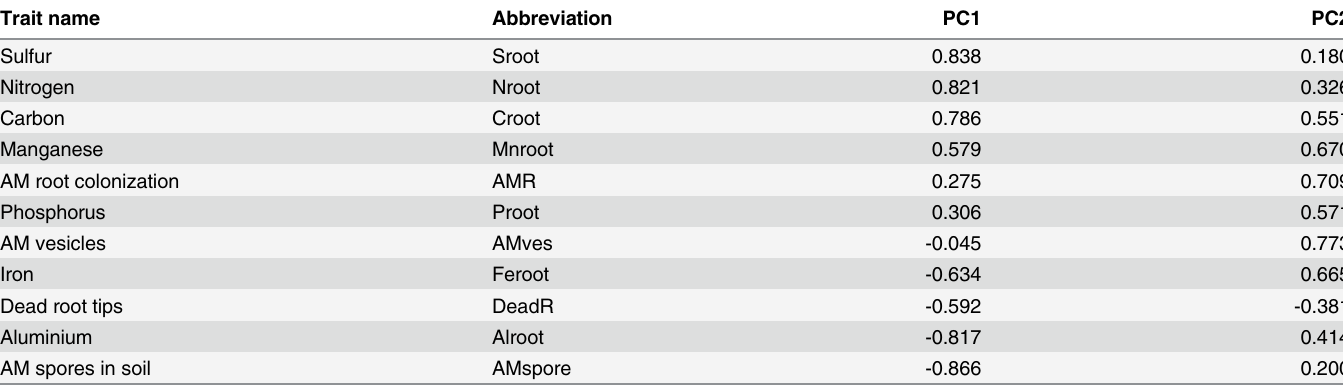
(PC2) of the variation, respectively (Fig 4). PC1 separated the land use systems with the rain Table 2. PCA loadings for correlations of root traits with PC1 and